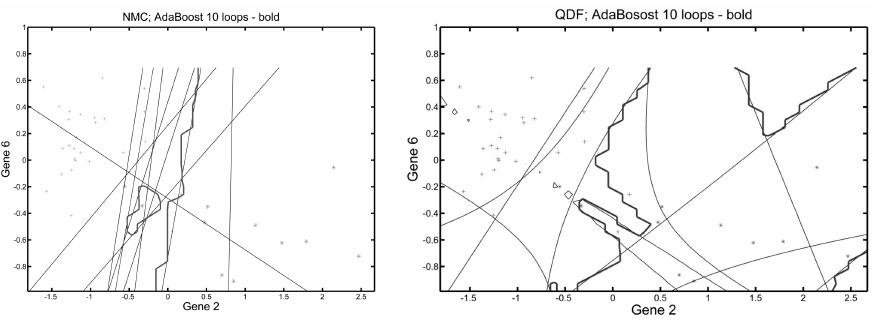
Figure 11. Ten loops with constituent and boosting boundaries. Left and bold: boosted Nearest Mean Classifier – Apparent err. = 0.05, CV = 0.105 (SD = 0.02), L1o = 0.105. Right and bold: boosted QDF-Apparent err. = 0.08, CV = 0.13 (SD = 0.05), L1o =